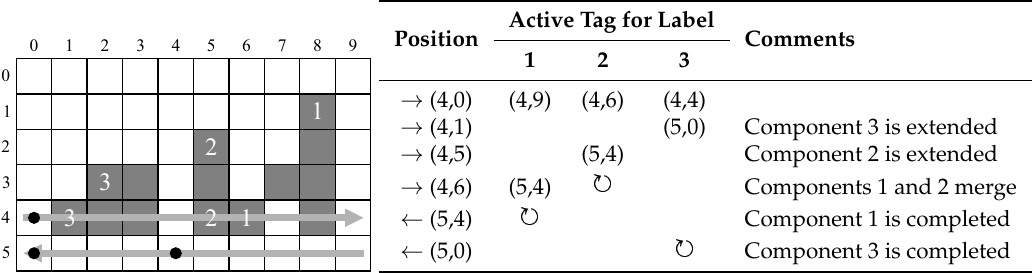
Figure 5. Example for detection of finished connected component at position X . (cid:247) indicates when the label is recycled.